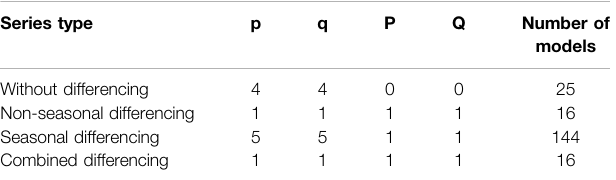
TABLE 5 | Orders of parameter and number of models required for the six-month drought index. Series